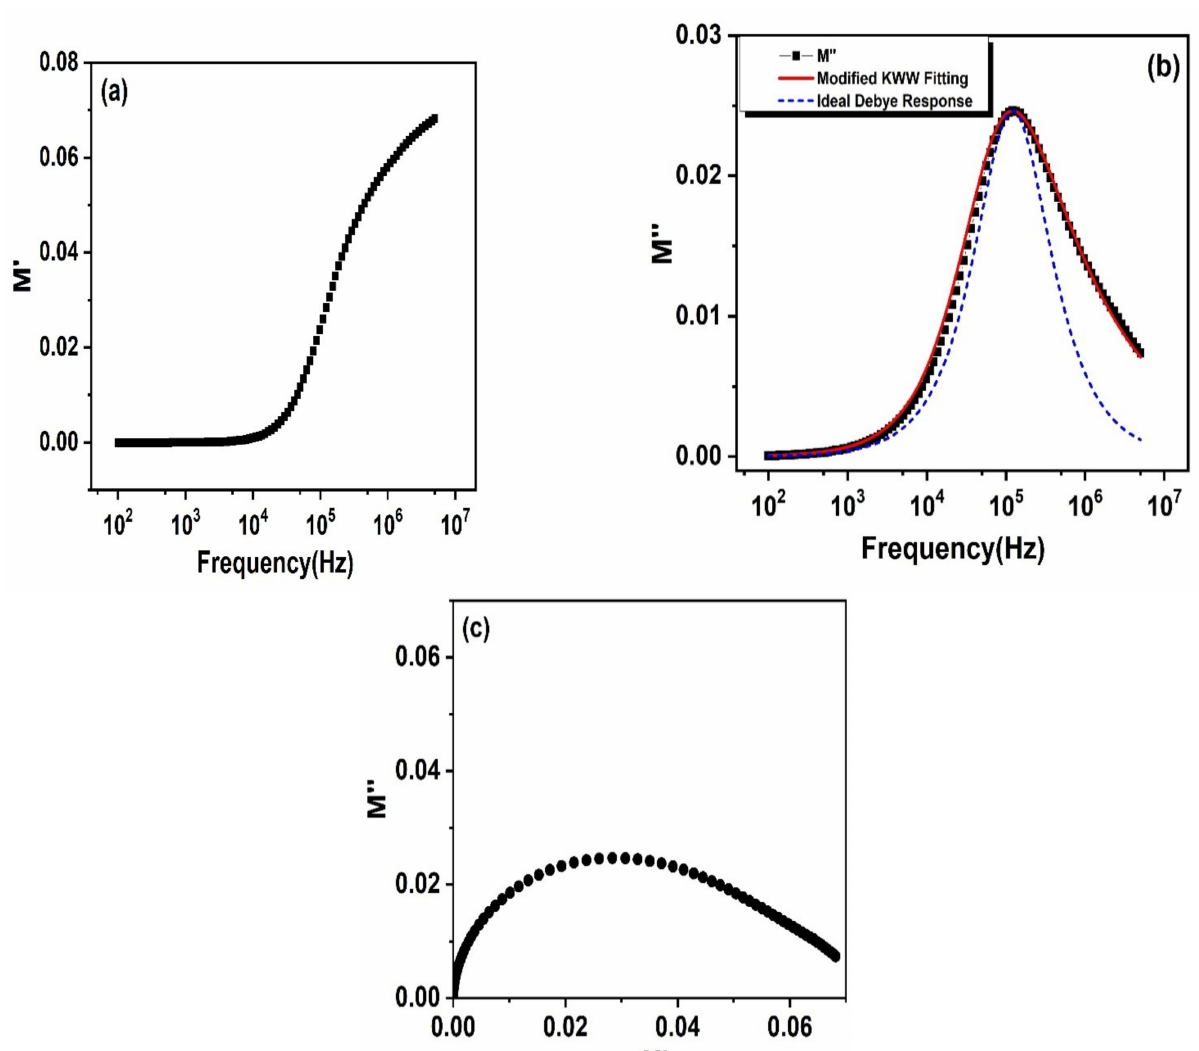
Figure 9. Frequency relying upon the response of ( a ) M (cid:48) ; ( b ) M (cid:48)(cid:48) ; ( c ) M (cid:48)(cid:48) verses M (cid:48) by electric modulus to study the reliance of electrical response on grains plus grain boundary of